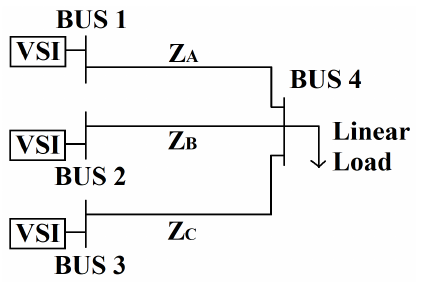
Figure 3. Microgrid of four